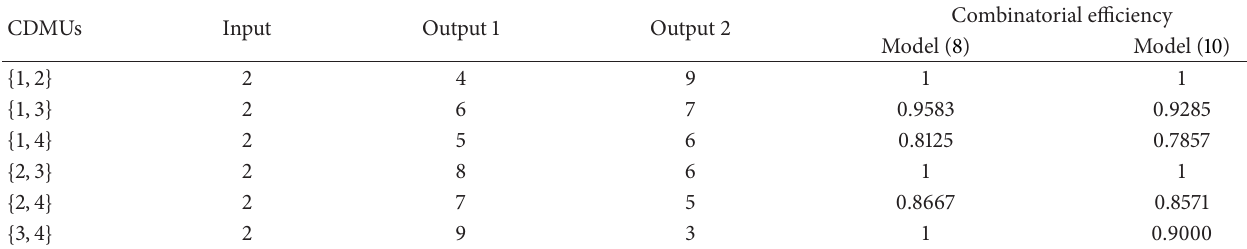
Table 3: Combinatorial efficiency evaluation by models (8) and (10).